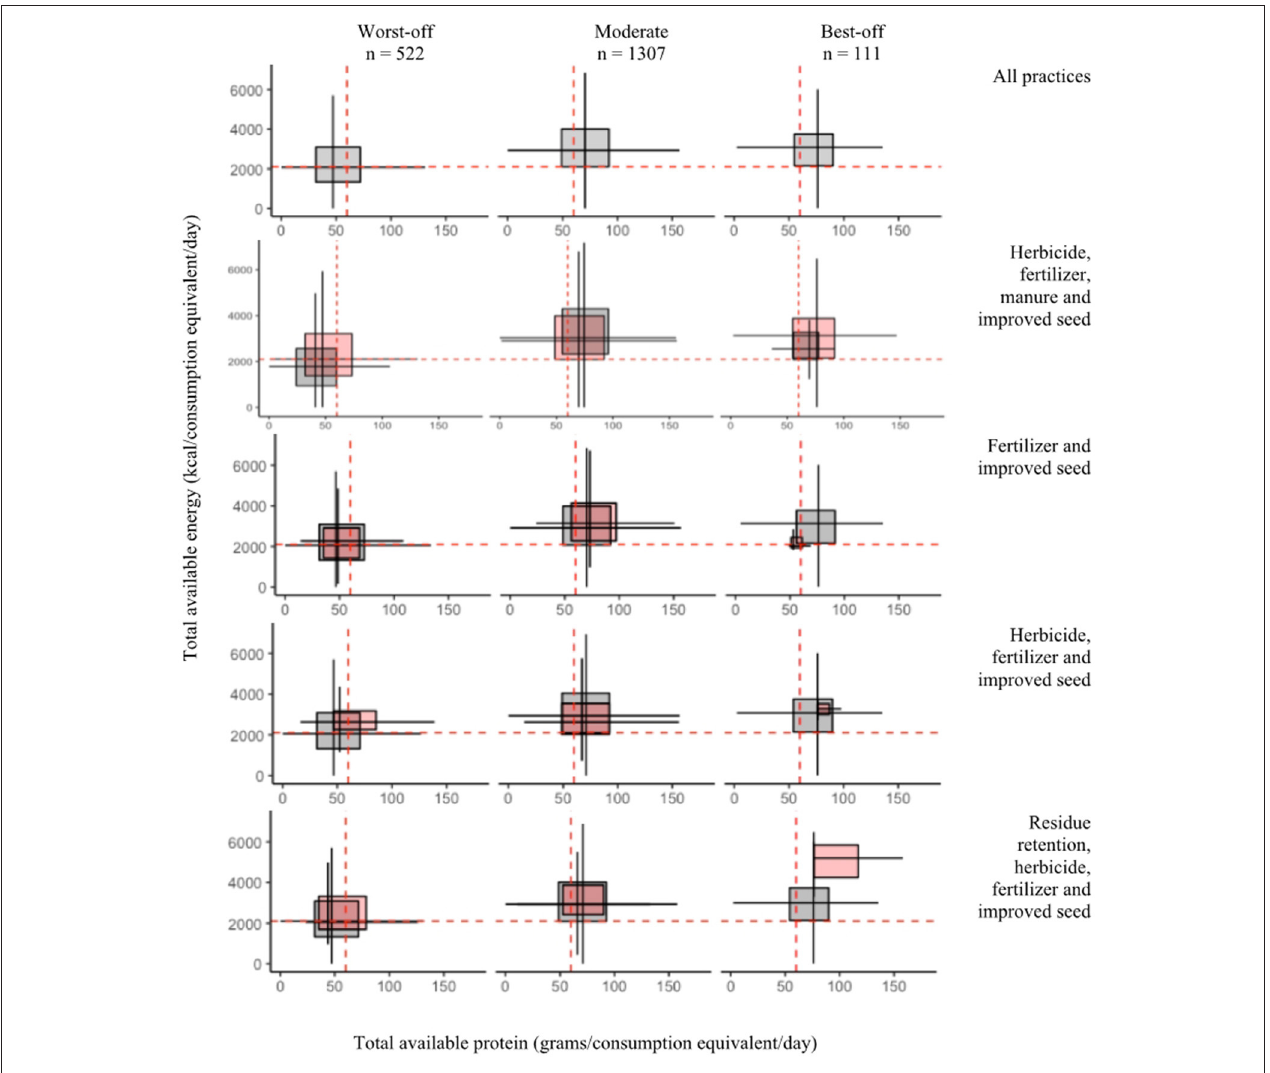
FIGURE 2 | Spatial distribution of the seasonal rainfall anomaly ratio across the sampled households in Ethiopia and Mozambique. The anomaly ratio is calculated as the difference between the survey period and the long-term average, divided by the average difference between the specified months and the long-term average. Seasonal anomaly ratios are shown for each main growing season prior to the survey and demonstrate the range of conditions experienced over the survey years. The histograms plot the rainfall percentile received over the survey